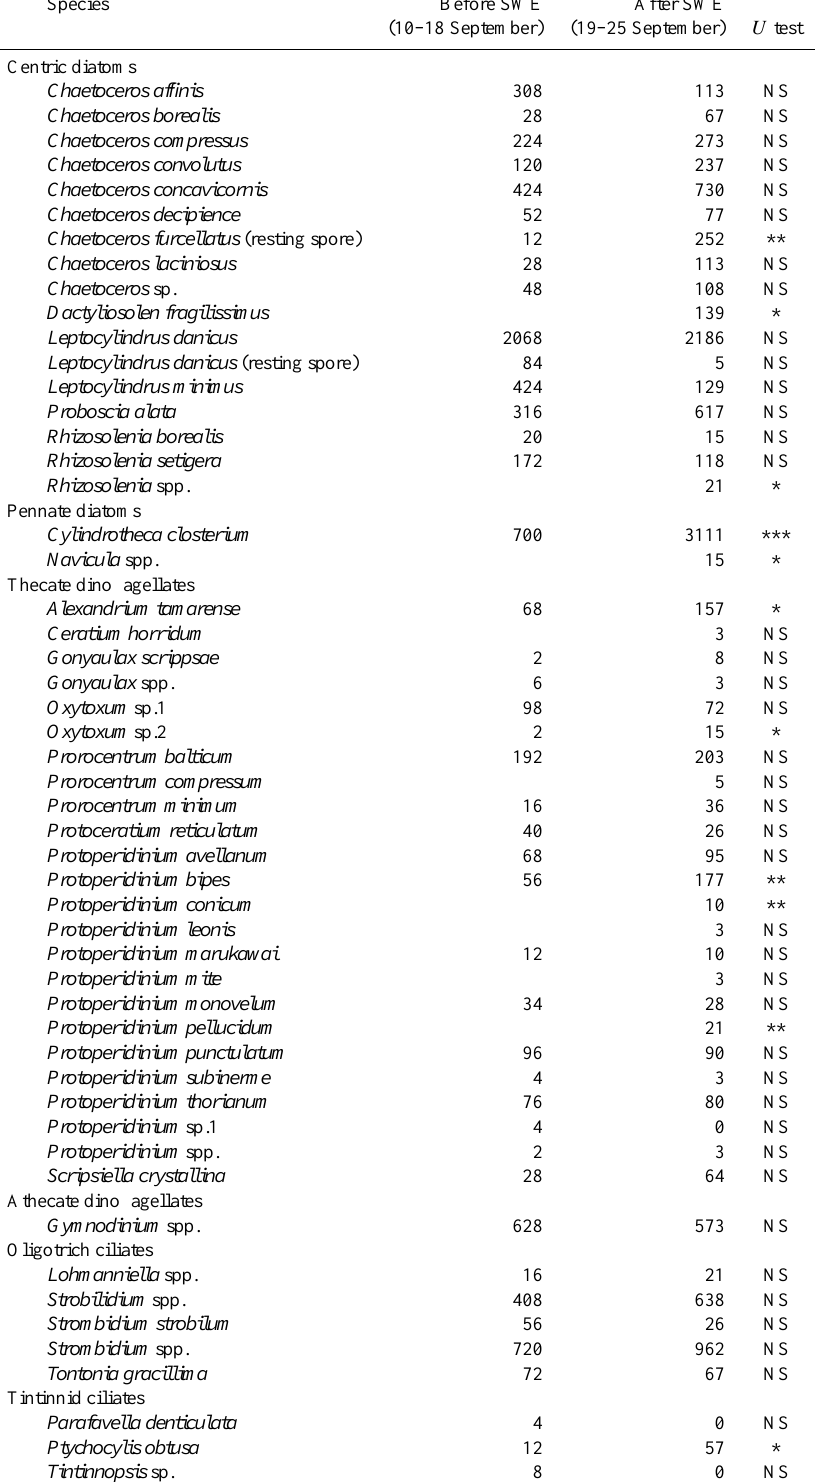
Table 1. List of microplankton species and their mean cell densities (cellsL − 1 ) at a single station in the Chukchi Sea between 10 and 18 September (before SWE) and 19 and 25 September (after SWE) 2013. NS: not significant; *: p < 0 . 05; **: p < 0 . 01; ***: p < 0 .